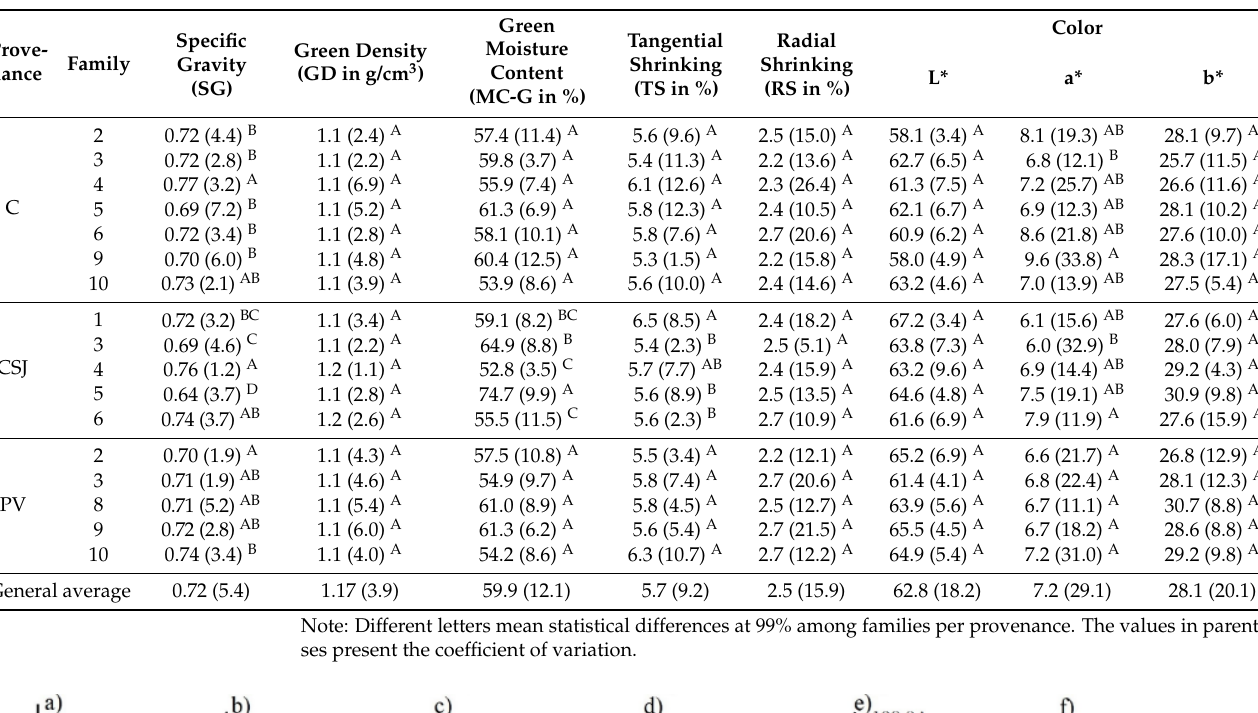
Table 2. Physical properties at 8-years-old among native provenances and families of Dipteryx panamensis in Costa Rica.